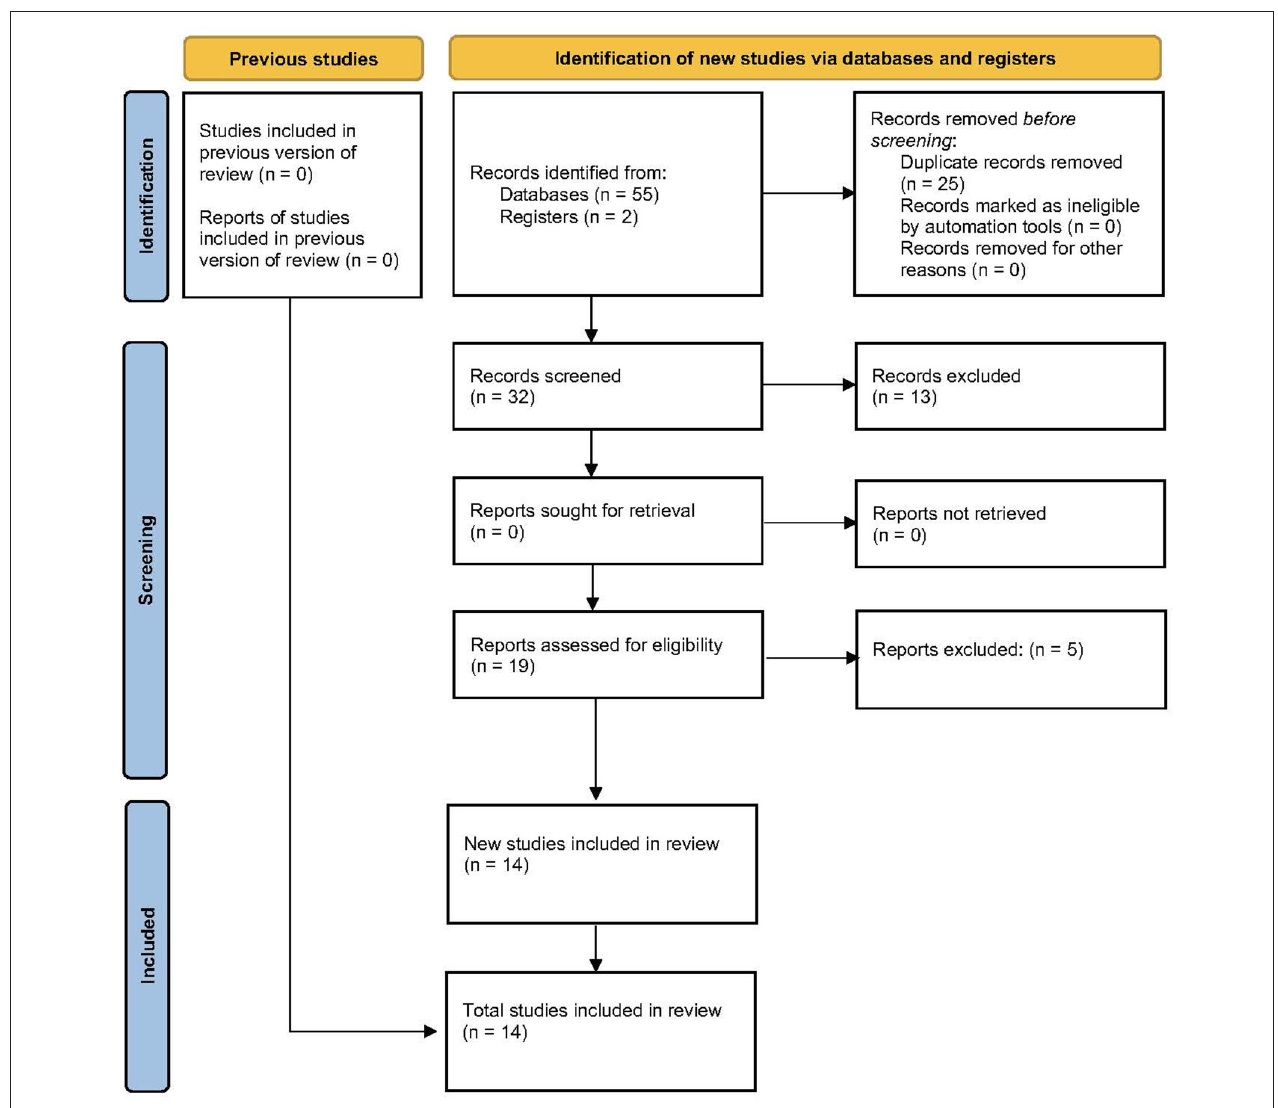
FIGURE 1 | Flow diagram of the study retrieval